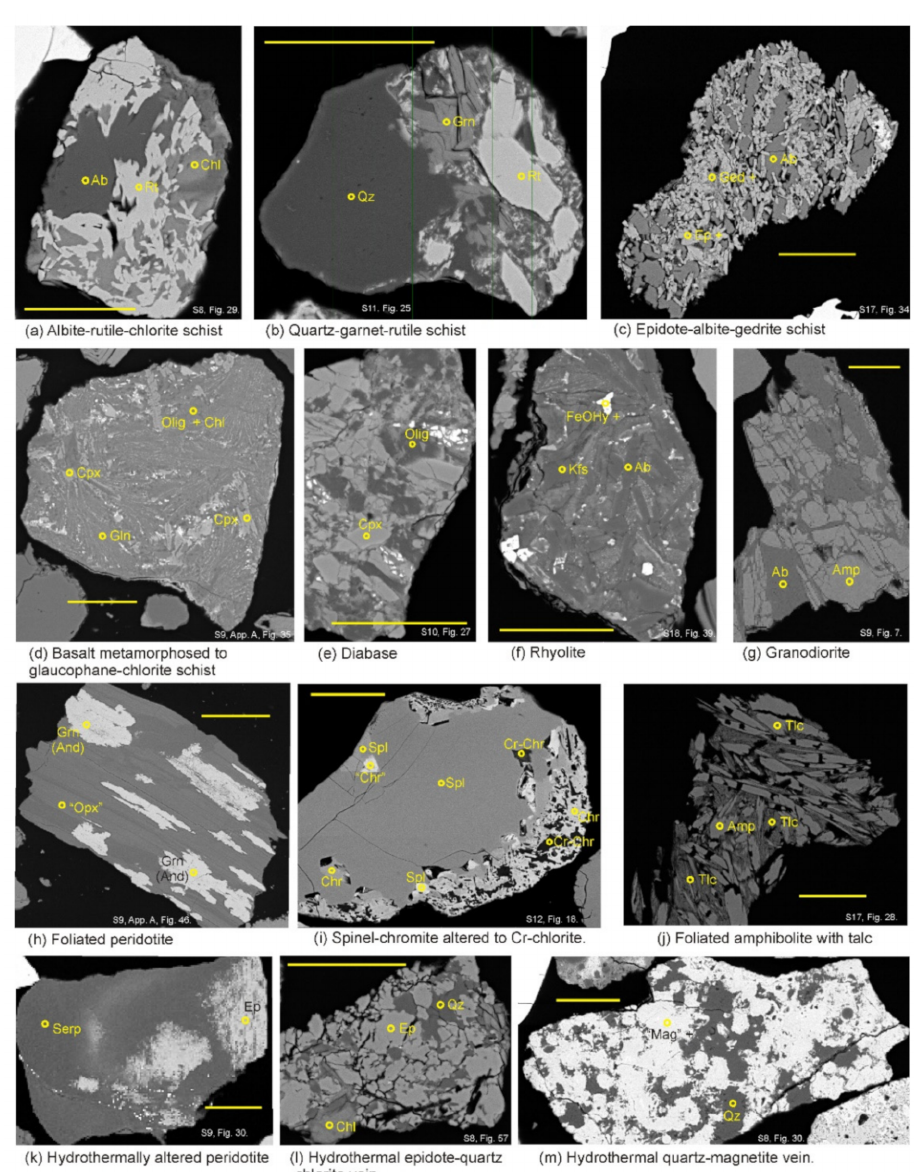
Figure 9. Backscattered electron (BSE) images of representative lithic clasts. Scale bar is 50 µ m. Definition of types is given in Section